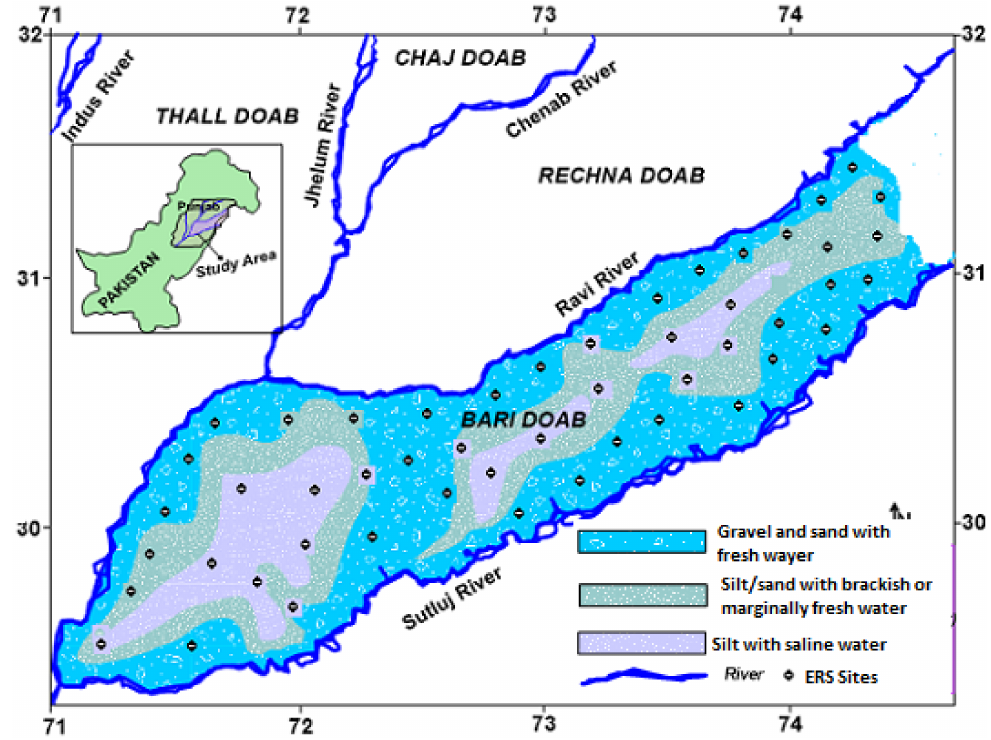
Figure 1. Hydrogeological map along with location Of ERS sites of Bari Doab (after